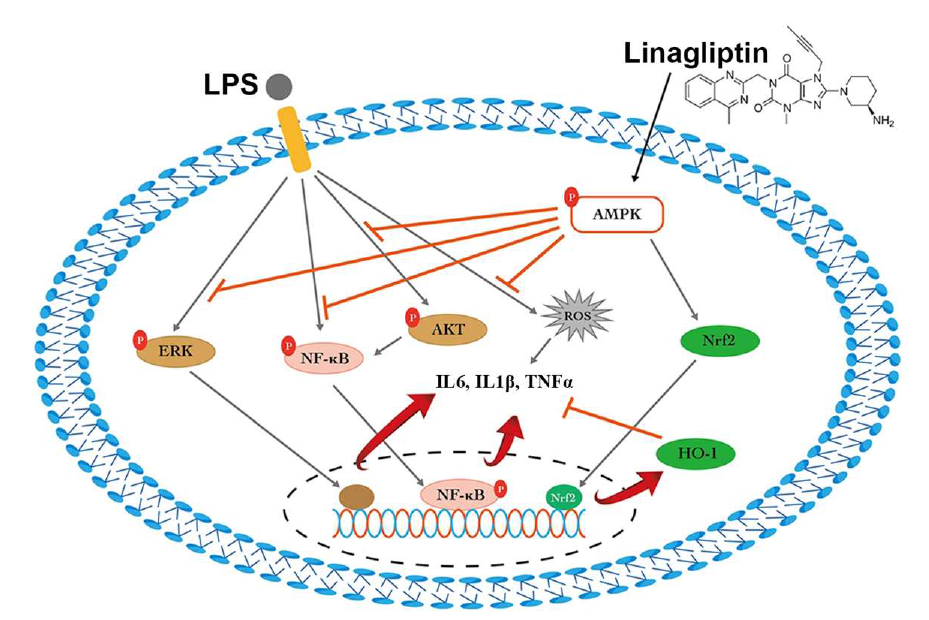
Figure 8. Schematic summary graph of the protective mechanism of linagliptin against lipopolysaccharide (LPS)-induced kidney injury by restoring the AMP-activated protein kinase (AMPK) pathway, nuclear factor erythroid 2-related Figure 2. and heme oxygenase 1 (HO-1) protein, and decreasing pro-inflammatory cytokines (tumor necrosis factor alpha (TNF- α ) and interleukin 1 beta (IL-1 β , IL-6)), attenuating reactive oxidative species (ROS) overproduction. NF κ B, nuclear factor kappa-light-chain-enhancer of activated B cells; AKT, protein kinase B; ERK, extracellular signal-regulated kinases. Inflammation plays a central role in the development of diabetic kidney disease. Over time, chronic inflammation increases the renal interstitial macrophage and dendritic cell populations, recruits additional inflammatory cells, and further induces the release of numerous pro-inflammatory cytokines (such as IL-1, IL-6, IL-18, and TNF) and chemoat- tractant molecules (such as CCL2 (also known as MCP1) and CX3C-chemokine